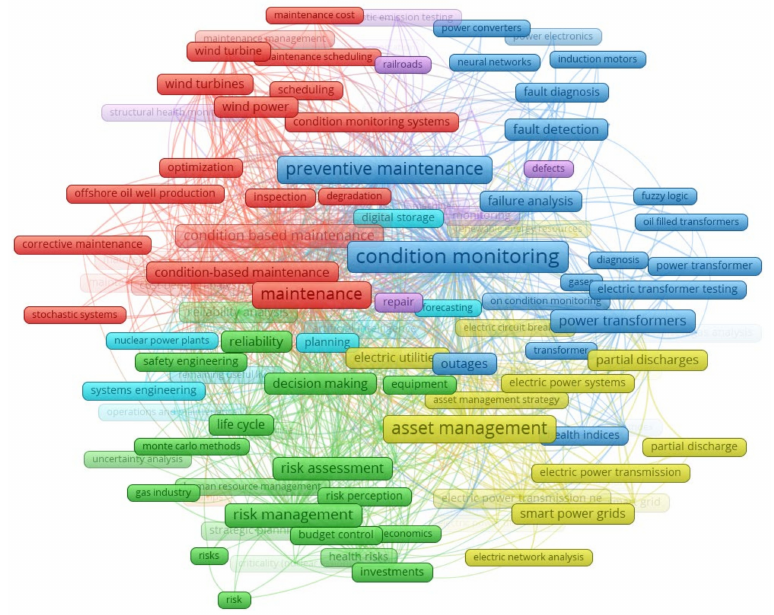
Figure 2. Network visualization of keywords from Scopus